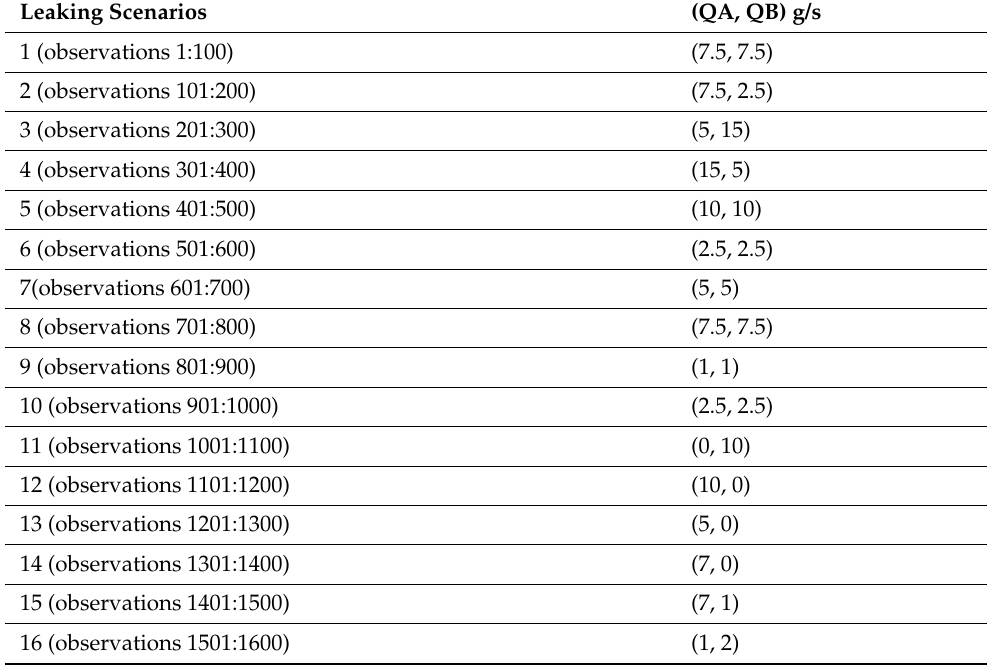
Table 2. Hazardous-Gas-Leaking Scenarios Taken into Account for Multi-Sensor Data-Driven Model Building.